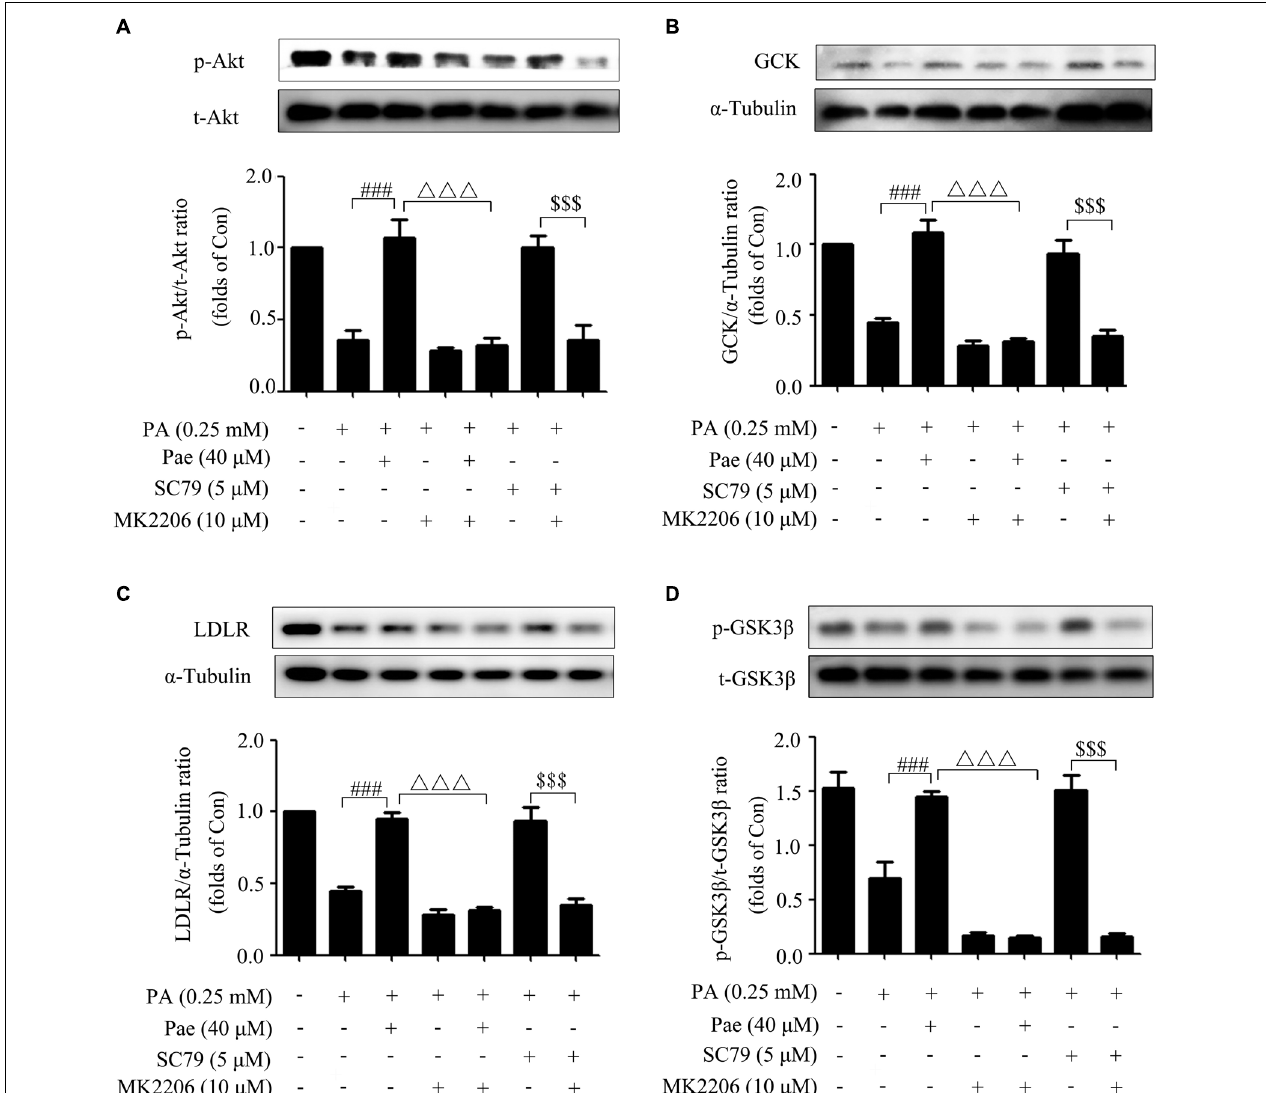
FIGURE 5 | Paeonol regulated LDLR and GCK through Akt. (A) MK2206 blocked the paeonol-induced up-regulation of p-Akt. (B,C) MK2206 inhibited the elevated levels of GCK and LDLR induced by paeonol or SC79. (D) MK2206 blocked the paeonol-induced up-regulation of p-GSK-3 β . All experiments were performed at least three times with similar results. ### p < 0.001 vs. PA (0.25 mM); (cid:77) (cid:77) (cid:77) p < 0.001 vs. PA + Pae; $$$ p < 0.001 vs. PA +